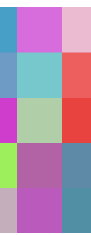
Figure 1. Sample image representing a 25 day period with HLC as input.